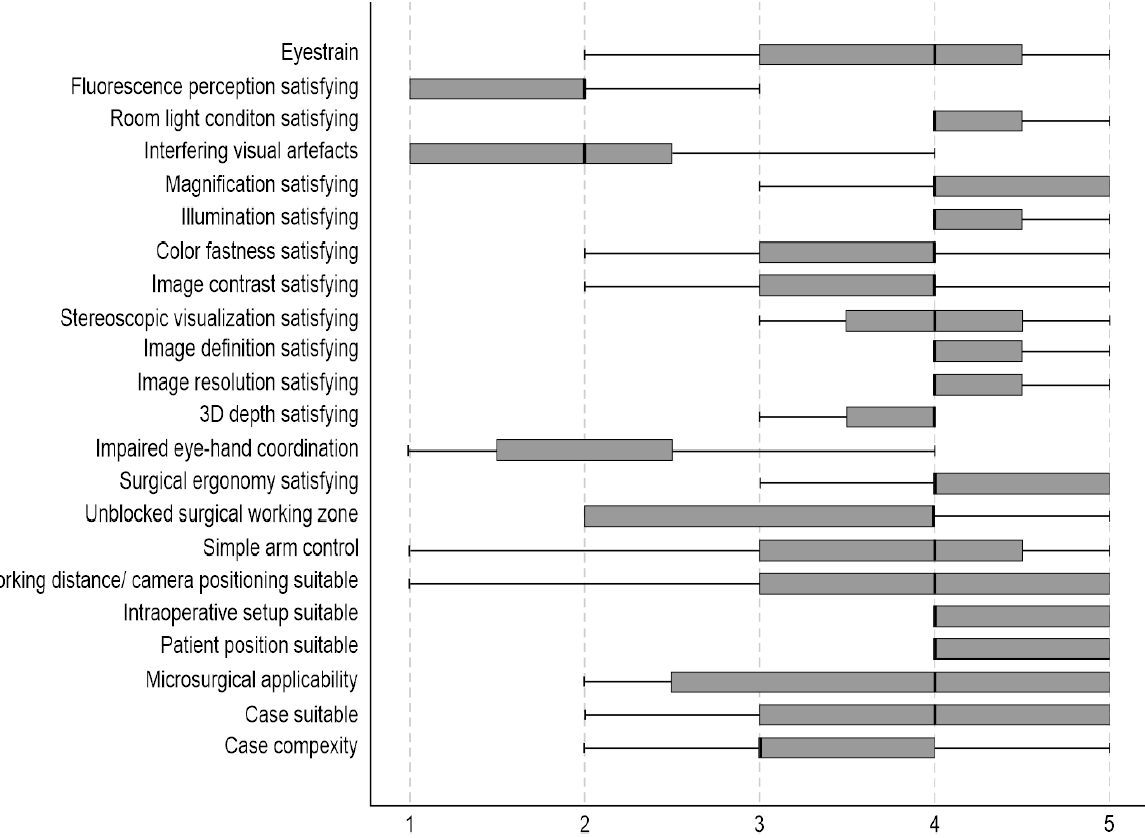
Figure 8. The first questionnaire evaluated the surgeon’s satisfaction regarding the applicability of Aeos. Factors influencing the applicability are listed on the y -axis. X -axis shows the level of agreement, where 0 is full disagreement, and 5 is full agreement. Boxplots illustrate the median agreement.